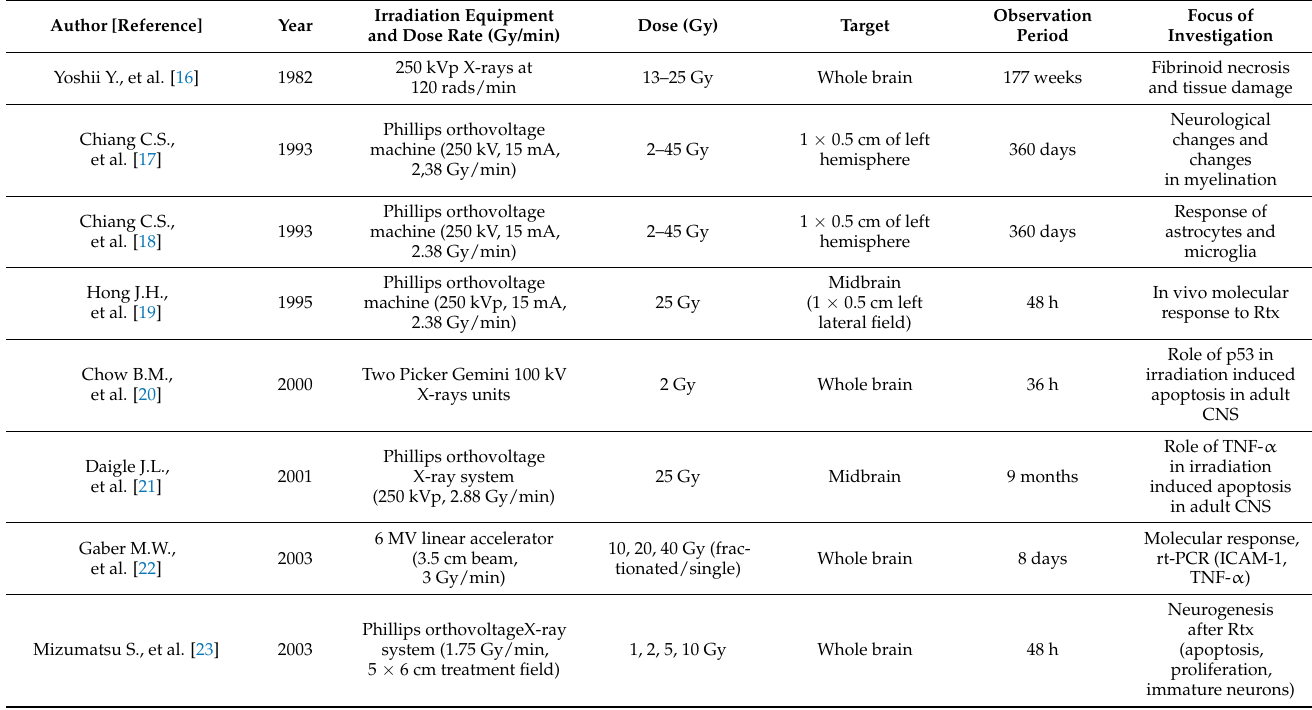
Table 1. Mouse models used for intracranial irradiation